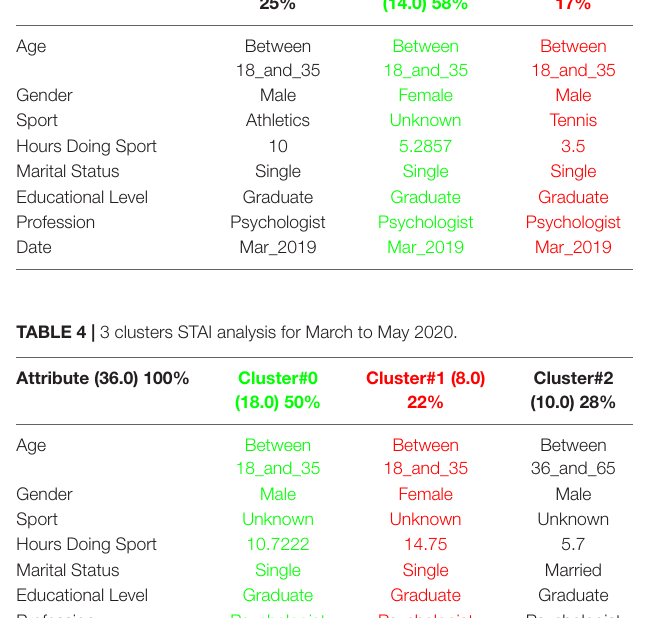
Steps 2 and 3 are followed iteratively until there are no more changes.